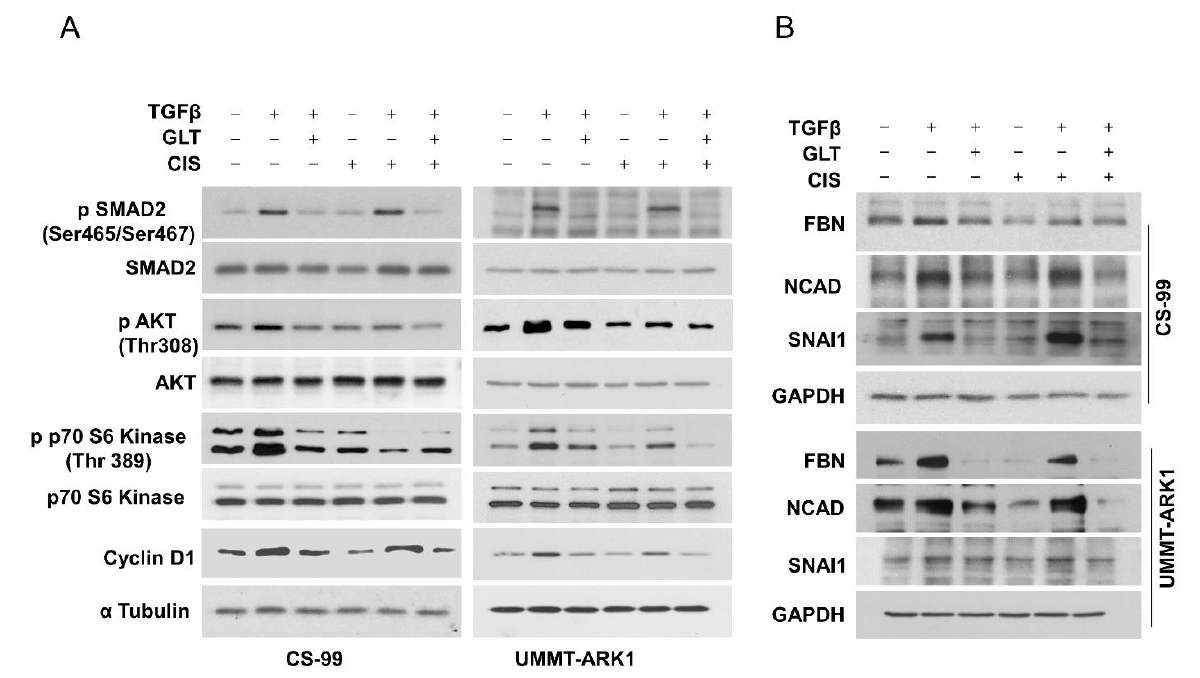
FIGURE 3: GLT inhibits canonical and non- canonical TGFβ signaling. CS-99 and UMMT-ARK1 cells were grown on a thin layer of Matrigel and treated with TGFβ1, GLT and Cisplatin (CIS, 2.5 µM) as represented, post 24 h of treatment, cell lysate was immunoblotted for (A) canonical and non- canonical markers of TGFβ1 signaling proteins along with Cyclin D1 as a marker for cell cycle progression and Tubulin as the loading control. (B) Effect of TGFβ1 and GLT + TGFβ1 treatmen t on the EMT markers (FBN – Fibronectin, NCAD - N-cadherin) were evaluated using immunoblotting, GAPDH was used as the loading